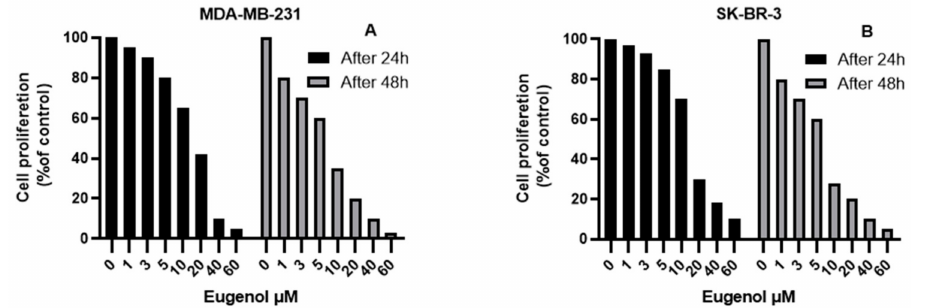
Figure 1. The effect of eugenol on MDA-MB-231 ( A ) and SK-BR-3 ( B ) cell viability using the MTT assay (values represent % of the control).